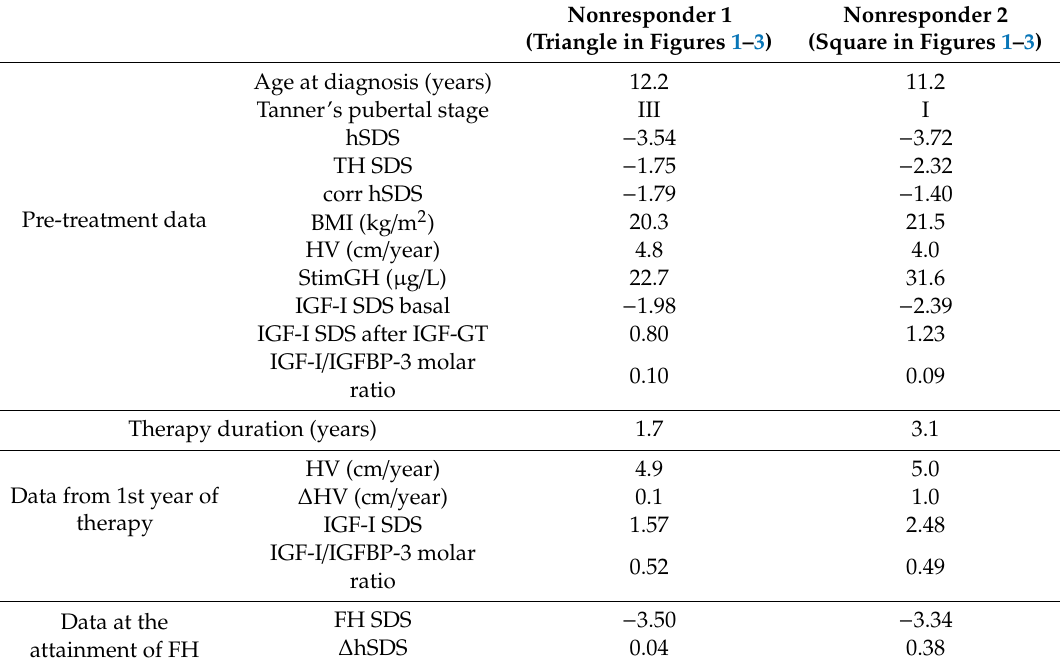
Table 3. Detailed Data of Nonresponders to rhGH